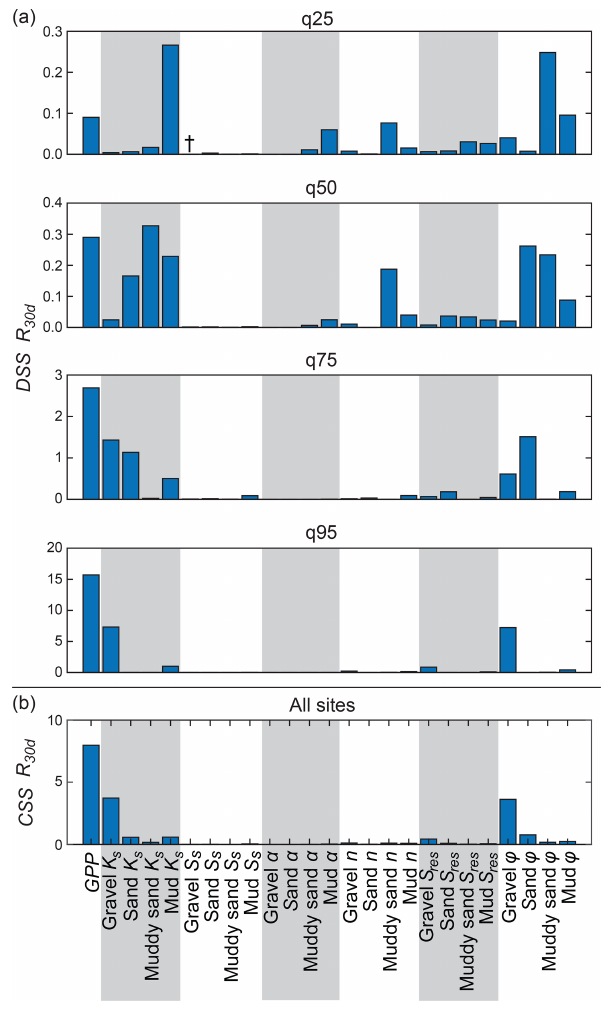
Figure 9. (a) Dimensionless scaled sensitivities (DSS) evaluated for each model parameter and model output R 30d at sites q25, q50, q75, and q95 and (b) composite scaled sensitivities (CSS) evaluated for each parameter and model output at all sites. DSS and CSS of parameters were scaled to the range [0, 1] (i.e., normalized). † DSS and CSS values below 0.001 are not